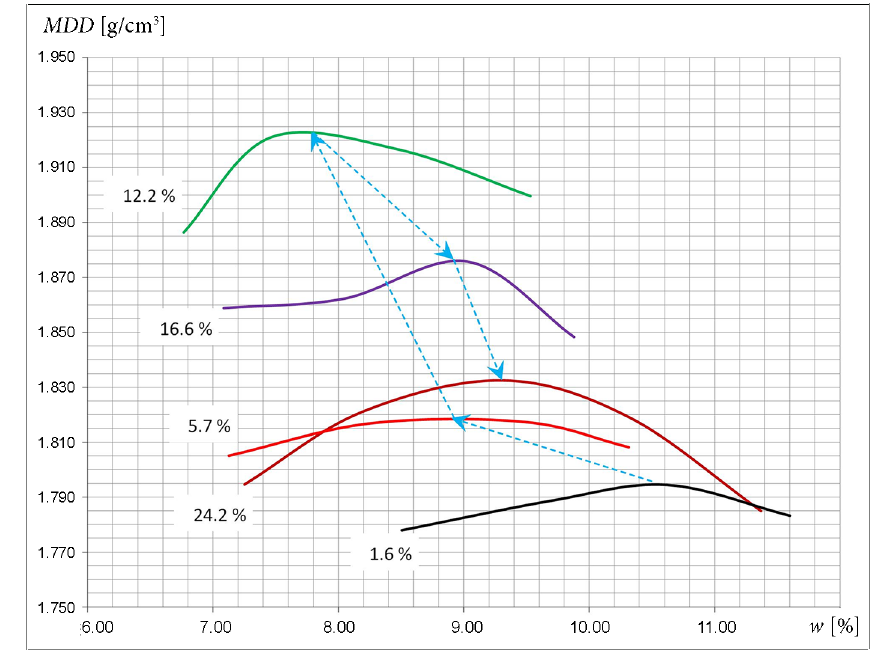
Figure 7. Changes of soil compactibility curves with different content of fine fractions Table 2. The increase of the moisture content in the middle of the height of the soil samples untreated to the penetration test